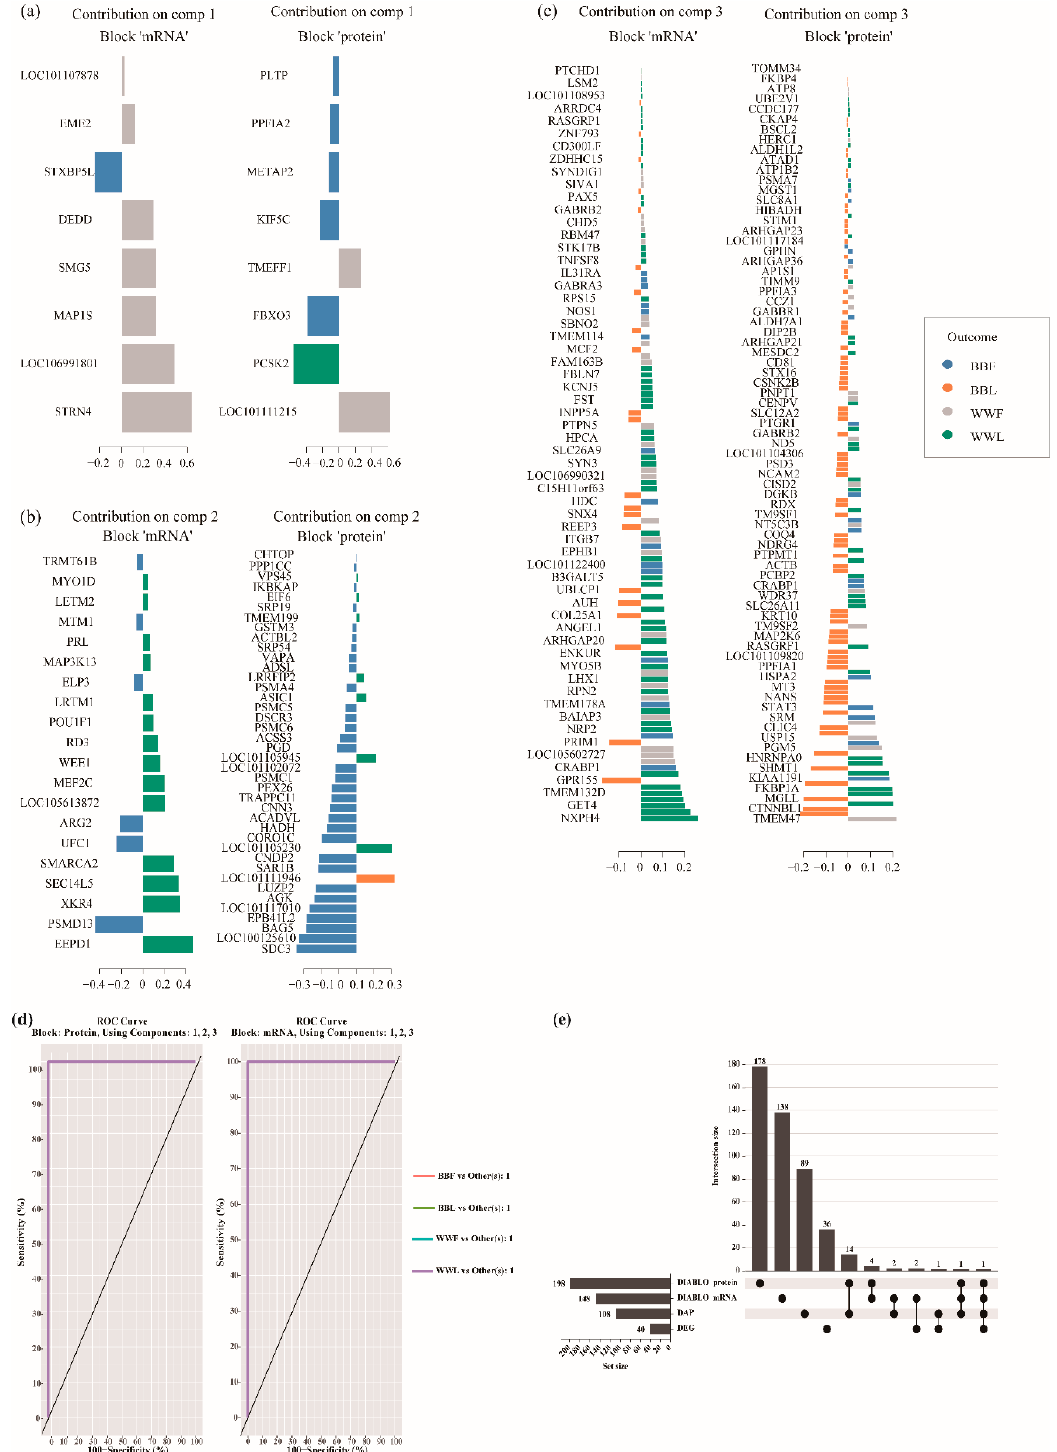
Figure 6. Targeted protein and mRNA panel and classification performance. DIABLO predicted the importance of multi-omics biomarkers, which were calculated on the basis of the absolute value of the loading vector weights shown for each block (protein and mRNA) and each component (component 1 ( a ), 2 ( b ), 3 ( c )). Each biomarker is color-coded according to its association with genotype and estrous stage. ( d ) Receiver operating characteristic area under the curve (ROC AUC) provides results of 1.00 separately using mRNAs and proteins from the three components in the classifier